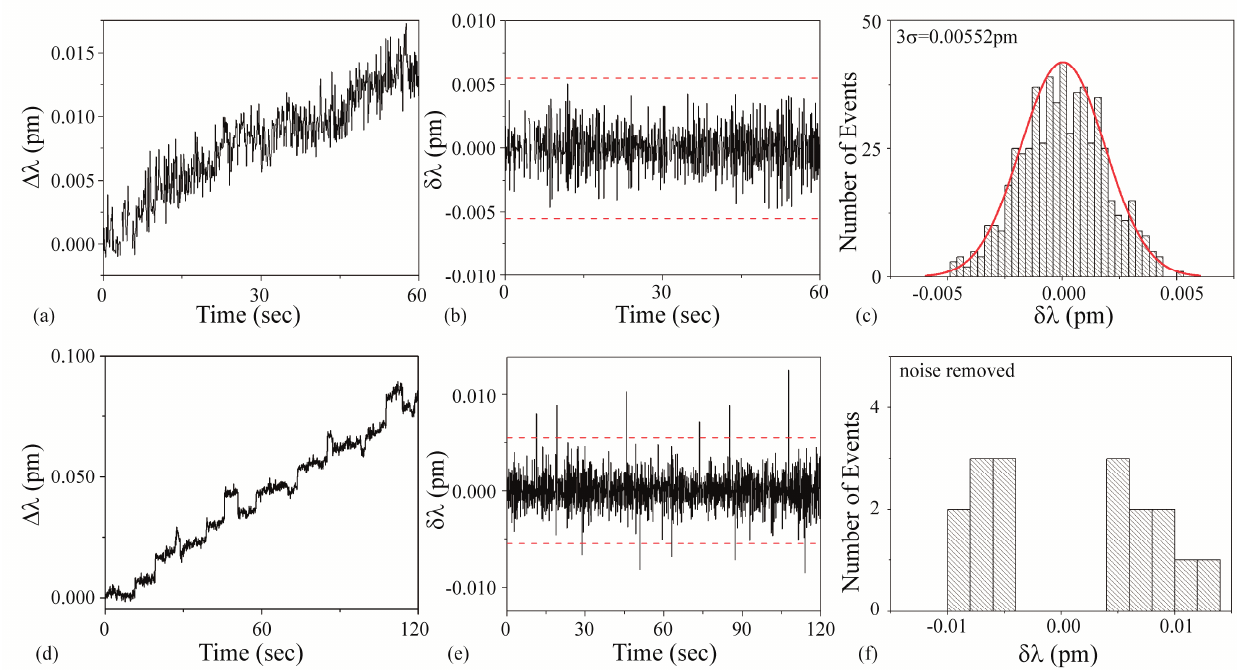
Figure 7. Dog solution: ( a – c ) background and ( d – f ) detection experiments. ( a )